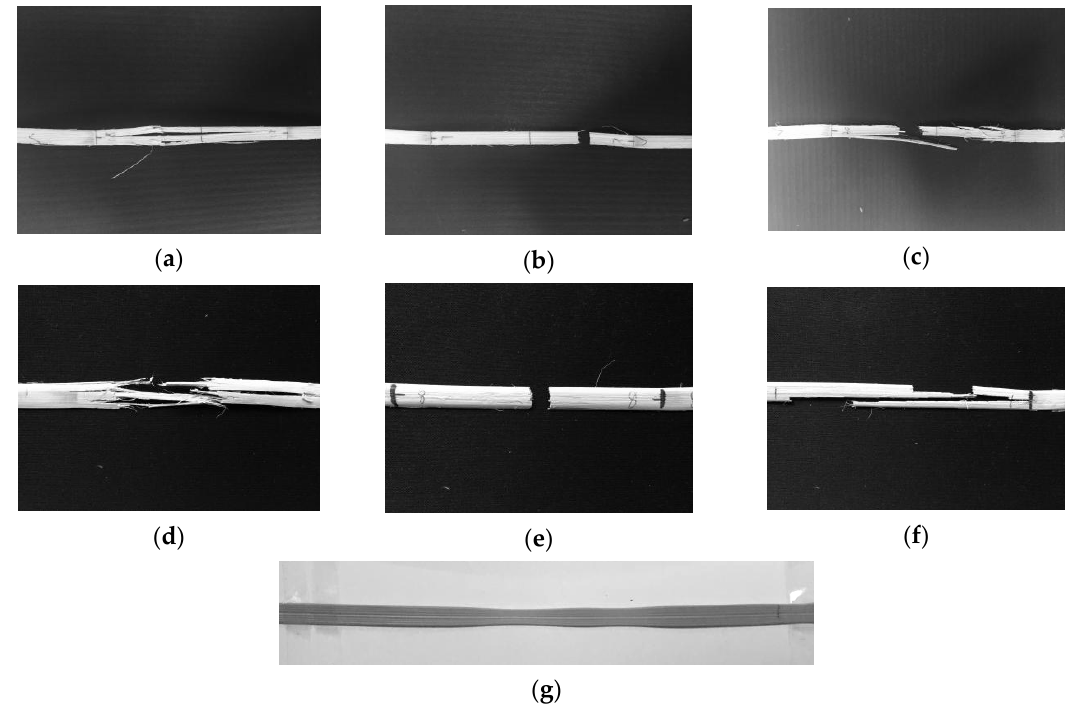
Figure 5. Typical tensile failure modes of natural rattan bast strips observed in test 1: splintering tension ( a ), brash tension ( b ), and combined splintering and brash tension ( c ); natural rattan core strips: splintering tension ( d ), brash tension ( e ), and combined splintering and brash tension ( f ) and typical failure modes of synthetic rattan strips: yield necking ( g ).